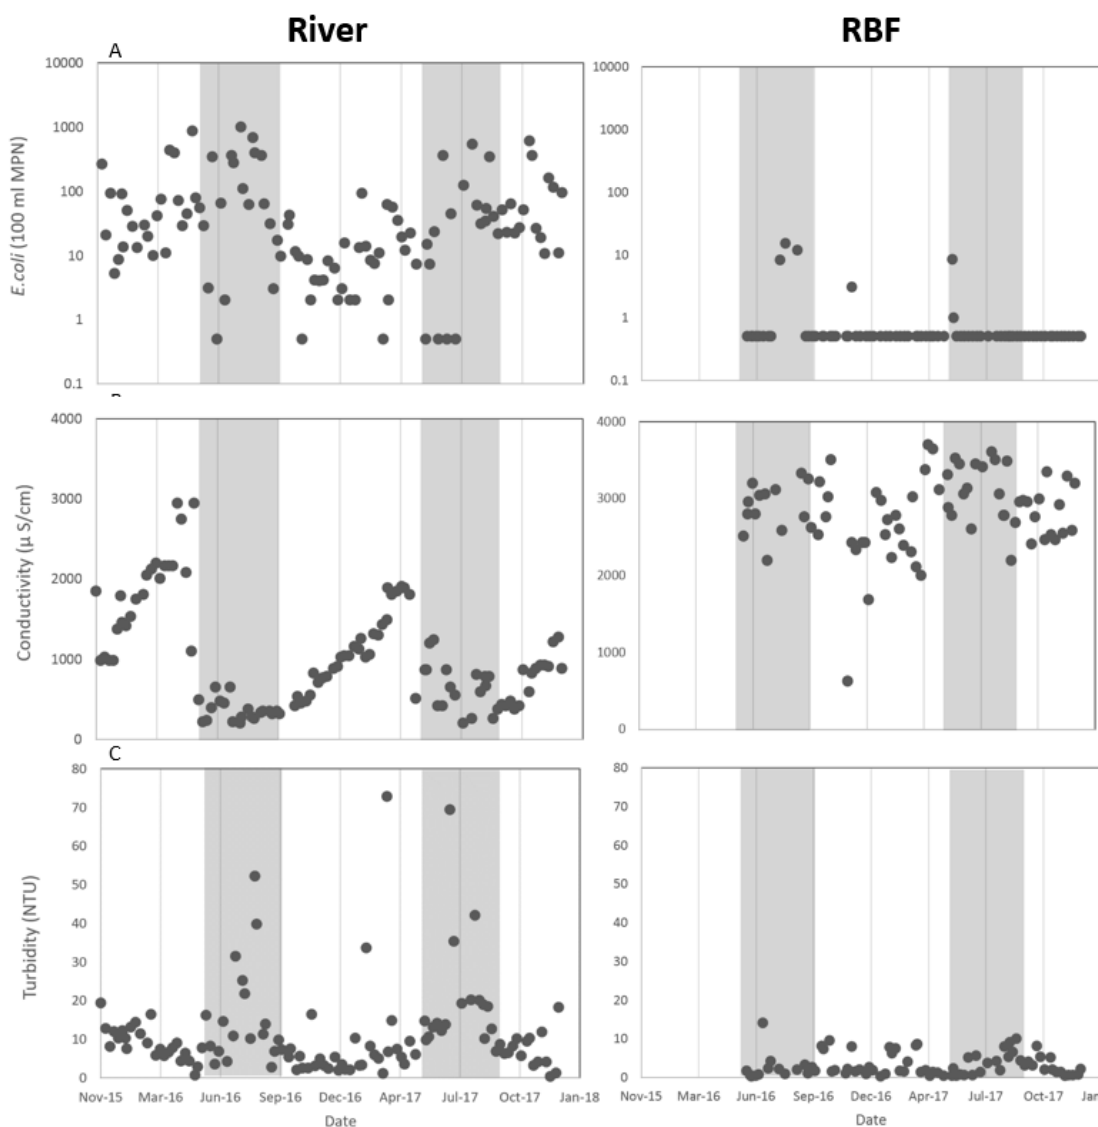
Figure 2. Measurements of ( A ) E. coli , ( B ) electrical conductivity, and ( C ) turbidity in the river ( left ) and RBF (right) water at Village 3. Shaded areas signify the monsoon season.